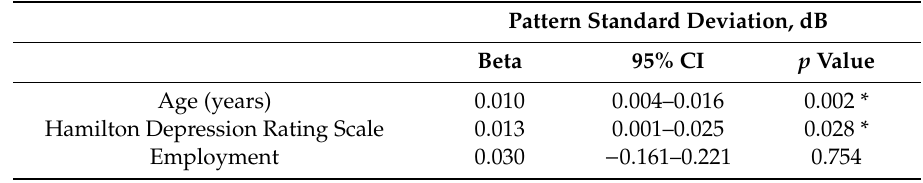
Table 3. Multivariate analysis of factors associated with pattern standard deviation on visual field tests.